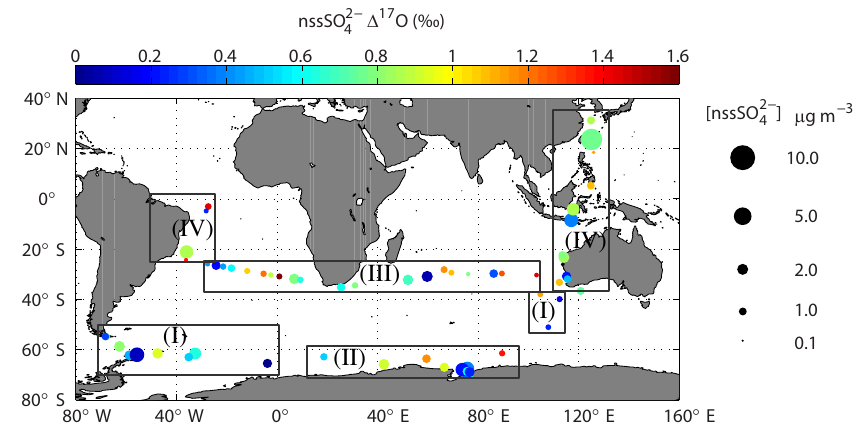
) (‰) and nssSO 2 − concentration (µgm − 3 ) for aerosol samples collected in the MBL during 4 4